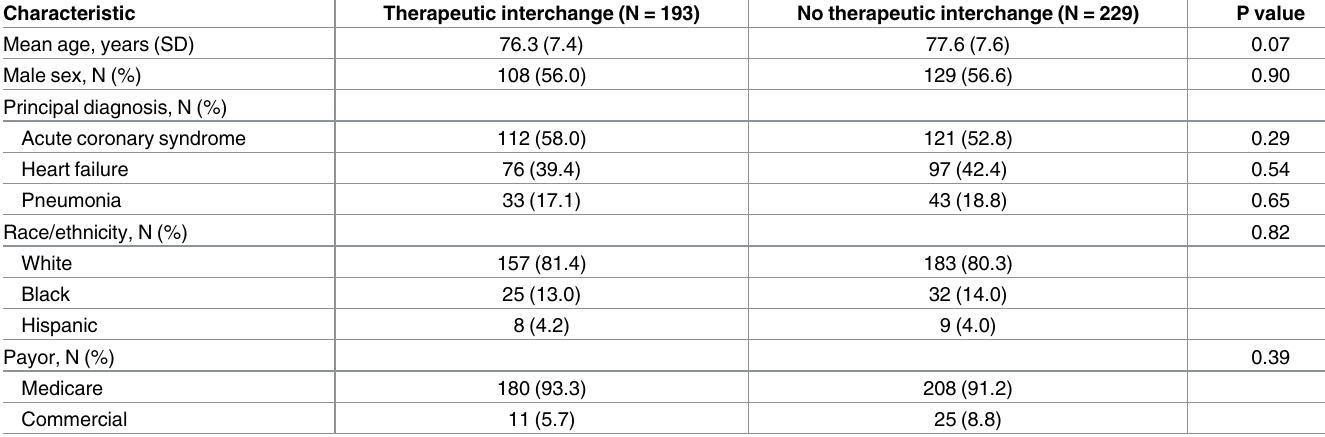
Table 2. Characteristics of patients in each cohort a .